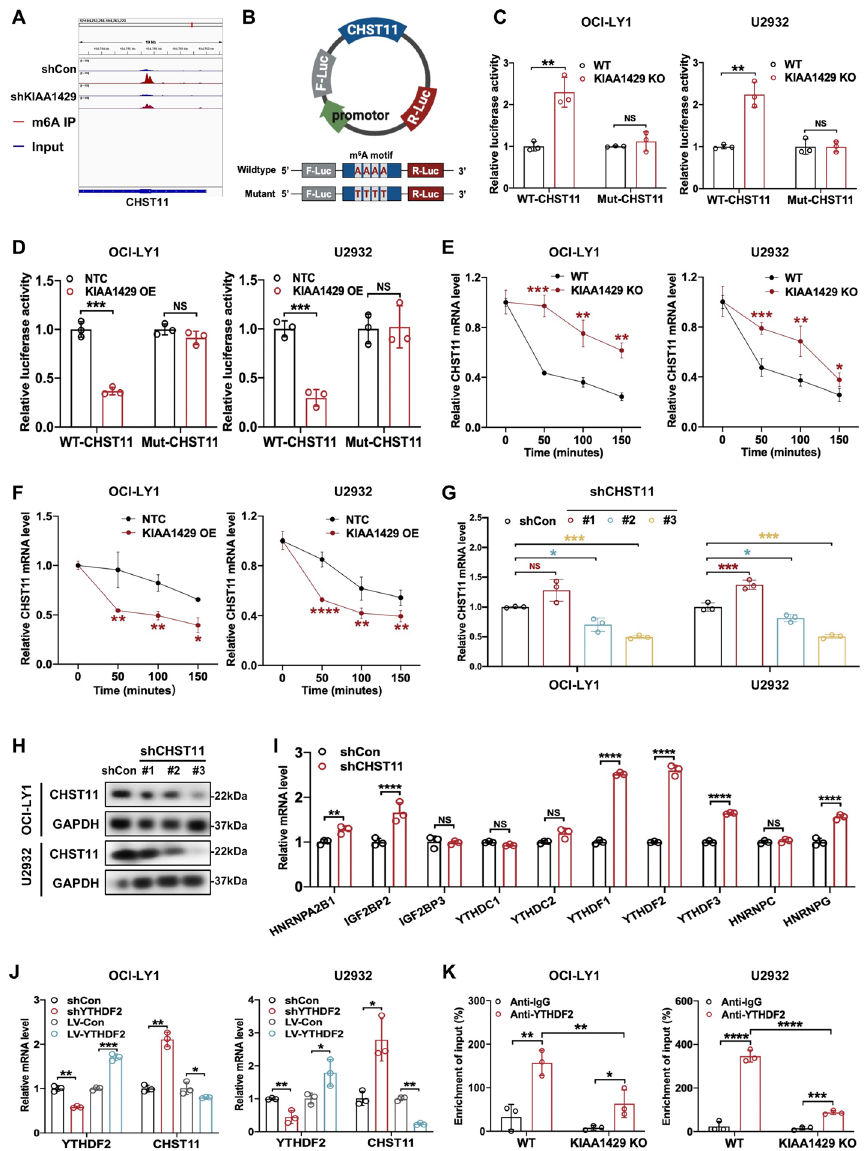
Fig. 5 KIAA1429 reduced the stability of CHST11 mRNA in an m6A-YTHDF2-dependent manner. A Visualization of m6A peak in CHST11 transcripts based on MeRIP-seq, and reduction of m6A levels of CHST11 by knockdown of KIAA1429. B Construction of a luciferase reporter containing wild-type CHST11 3 ′ UTR and CHST11 3 ′ UTR with a mutation at the m6A consensus sequence. C , D An analysis of relative luciferase activity was conducted in DLBCL cells with or without KIAA1429 knockdown or KIAA1429 overexpression. Triplicate data are shown as mean SD. ** p < 0.01; *** p < 0.001. E , F RT-qPCR was used to detect the ± expression of CHST11 after treatment with actinomycin D (5 μg/ml) at the indicated timepoints in KIAA1429 knockdown, KIAA1429-overexpressing, and corresponding control DLBCL cells. Result are presented as mean SD from three independent experiments. * p < 0.05; ** p < 0.01; *** p < 0.001; **** p < 0.0001. G , H ± Knockdown efficiency of CHST11 in DLBCL cells was verified at mRNA and protein levels. As a result of three independent experiments, mean SD is presented. * p < 0.05; *** p < 0.001. I RT-qPCR was utilized to ± determine the alterations in expression of m6A-binding proteins upon CHST11 knockdown. The results are shown as mean SD from three independent experiments. ** p < 0.01; **** p < 0.0001. J The relative mRNA ± levels of CHST11 were detected in DLBCL cells with YTHDF2 overexpression or knockdown. Data from three independent experiments are presented as mean SD. * p < 0.05; ** p < 0.01; *** p < 0.001. K Validation of direct ± binding between YTHDF2 and CHST11 mRNA was performed by RIP-qPCR. Data are expressed as mean SD ± from three independent experiments. ** p < 0.01; *** p < 0.001; **** p <